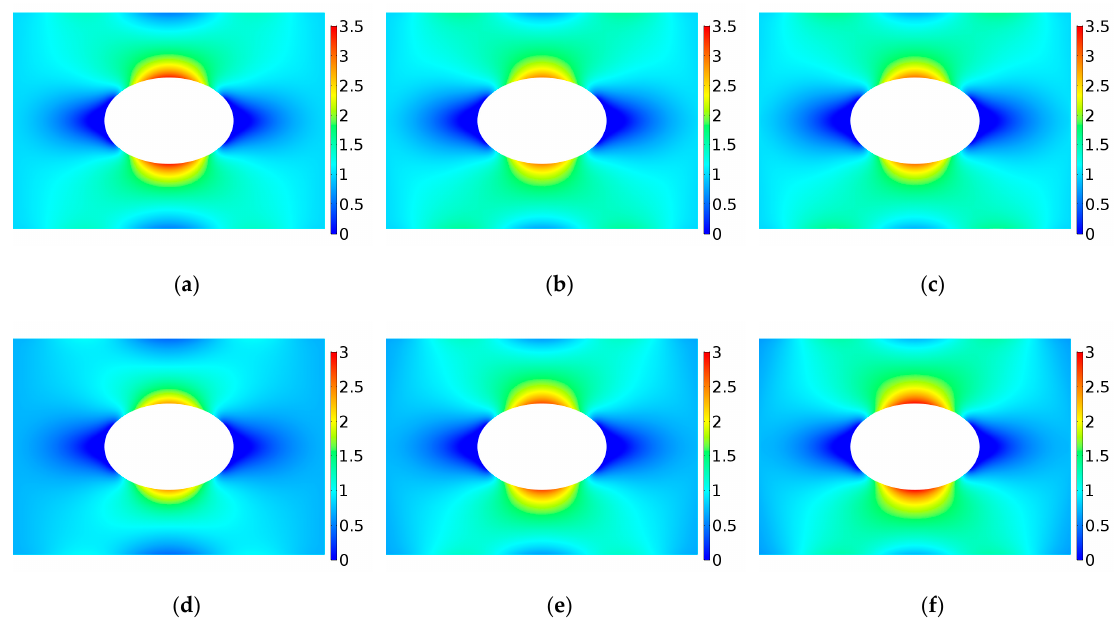
Figure 10. Variation of the damage factor ψ with power-law index under optimal condition of γ = 1. ( a )